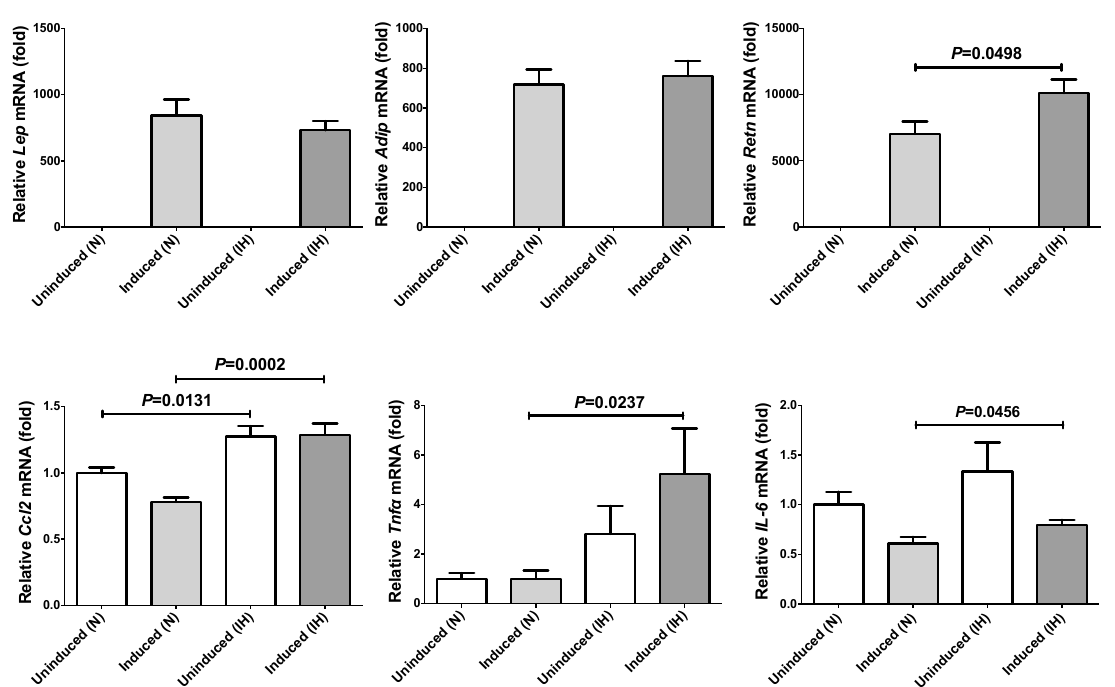
Figure 3. The mRNA levels of Lep , Adip , Retn , Ccl2 , Tnf α , and IL-6 in 3T3-L1 cells treated by normoxia or IH for 24 h. Figure shows relative comparison of mRNA expression in 3T3-L1 preadipocytes with 3T3-L1 adipocytes. The levels of the adipokine mRNAs were measured by real-time RT-PCR using Rig/RpS15 as an endogenous control. Data are expressed as mean ± SE for each group ( n = 4). The statistical analyses were performed using Student’s t -test. We further measured RETN, TNF α , and CCL2 protein in the culture medium by ELISA and found that the levels of RETN ( P = 0.0256), TNF α ( P = 0.0215), and CCL2 ( P < 0.0001) were significantly increased by IH in SW872 cells (Figure 4).